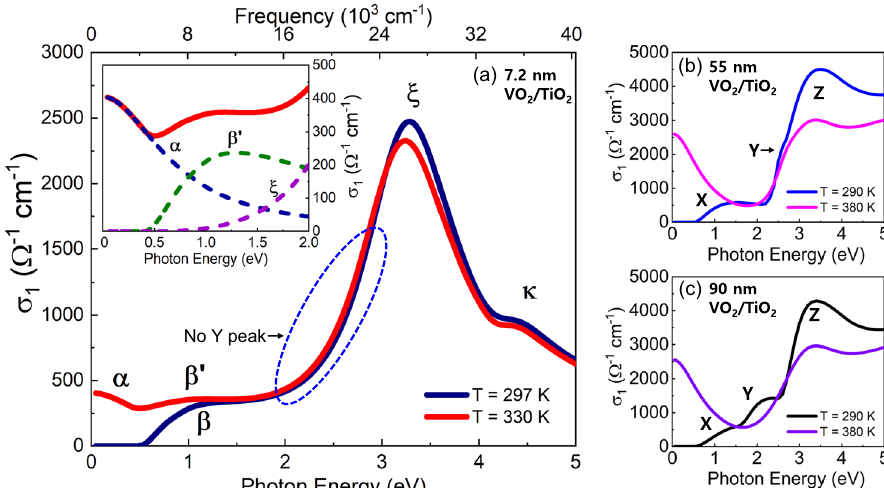
Fig. 4 Optical conductivity of VO 2 fi lms. a Real part of the optical conductivity ( σ 1 ) for the insulating (dark blue) and metallic (red) phases of the 7.2 nm thick VO 2 fi lm on rutile (001) TiO 2 as a function of photon energy. (inset) Zoomed in low energy region of σ 1 in the metallic phase. The dashed lines representing individual contributions of the free carrier Drude feature, α (blue), and the optical transitions, β ‘ (green) and ξ (purple). b Plot of σ 1 in the insulating (blue) and metallic (magenta) phases of a thick 55 nm VO 2 fi lm grown on rutile (001) TiO 2 . c Plot of σ 1 in the insulating (black) and metallic (purple) phases of a thick 90 nm VO 2 fi lm grown on rutile (001) TiO 2 . As expected, the Y peak in the thicker 90 nm fi lm is more prominent than in the 55 nm thick fi lm. The Y peak is also slightly red-shifted in the 90 nm thick fi lm due to a higher degree of strain relaxation compared to the 55 nm thick fi lm.